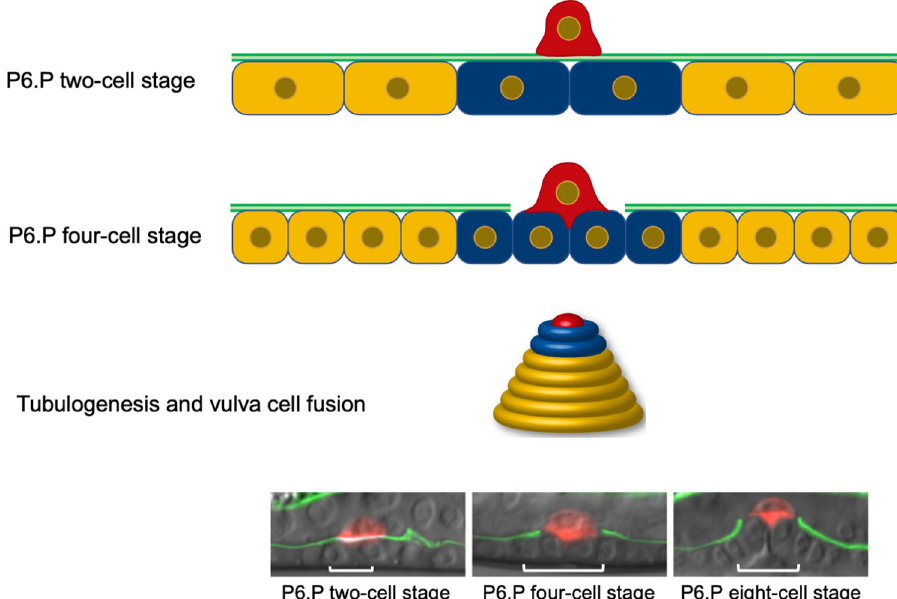
Fig 1. Schematic of C . elegans anchor cell invasion. The anchor cell must traverse the basement membrane to connect the uterus to the vulva. Lattmann and colleagues show that prereplication complex proteins are required for the ability of the anchor cell to invade through the basement membranes and induce the vulval progenitor cells to become vulva.